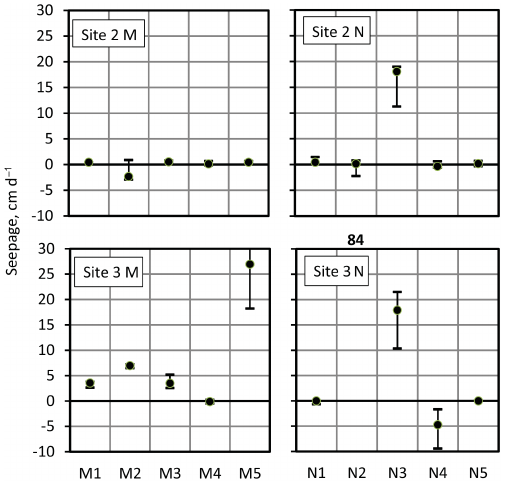
Figure 7. Median values of seepage flux. Error bars indicate maxi- mum and minimum measured values. Median value for site 3 N2 is 84cmd − 1